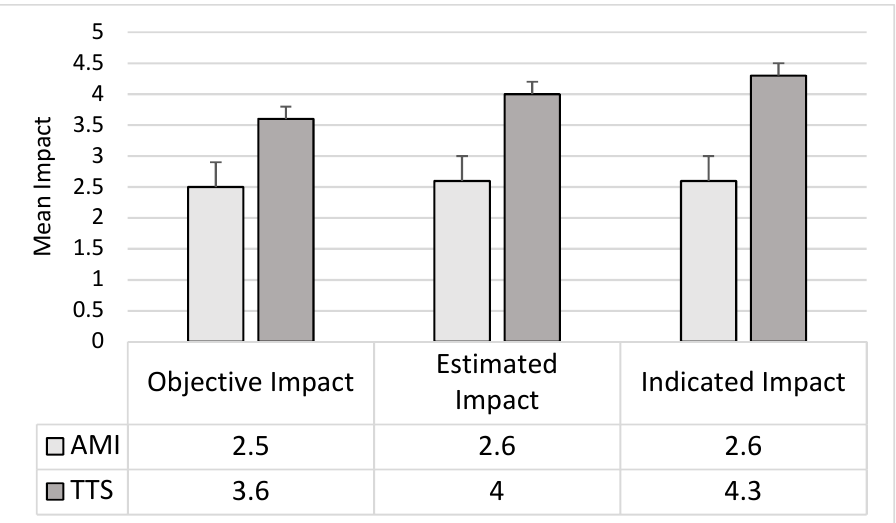
Figure 2. Mean and Std. Err. of the Trigger Impacts reported by the two groups of patients ( p refers to ANCOVA results) . AMI: Acute Myocardial Infarction; TTS: Takotsubo Syndrome.